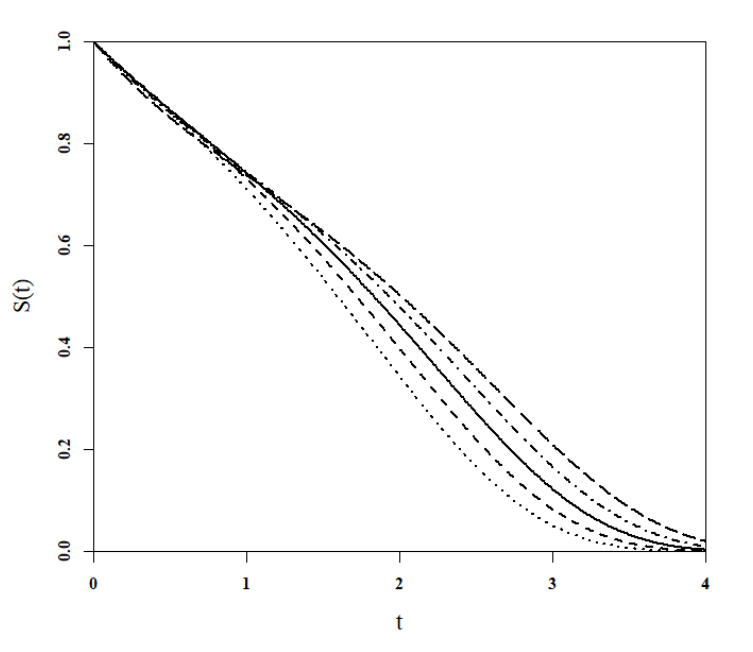
Figure 4. Survival curves of CH { 2,0.1 }